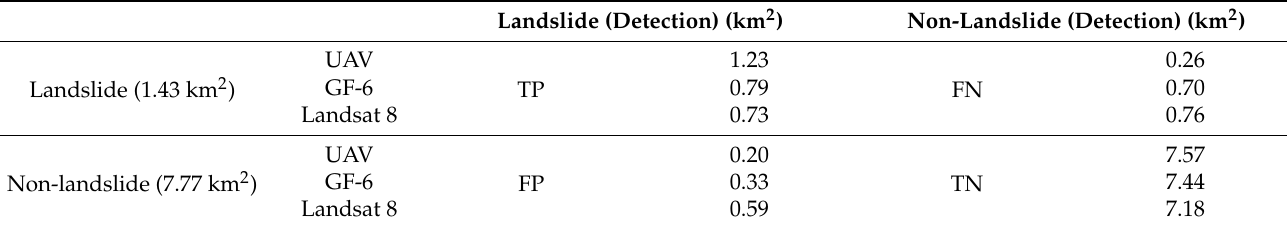
Figure 4. Detected areas in each image (( a ) correctly detected areas in UAV; ( b ) correctly detected areas in GF-6; ( c ) correctly detected areas in Landsat 8; ( d ) undetected areas in UAV; ( e ) undetected areas in GF-6; ( f ) undetected areas in Landsat 8; ( g ) misidentified areas in UAV; ( h ) misidentified areas in GF-6; and ( i ) misidentified areas in Landsat 8). Table 2. Landslide detection area results from remote sensing images.